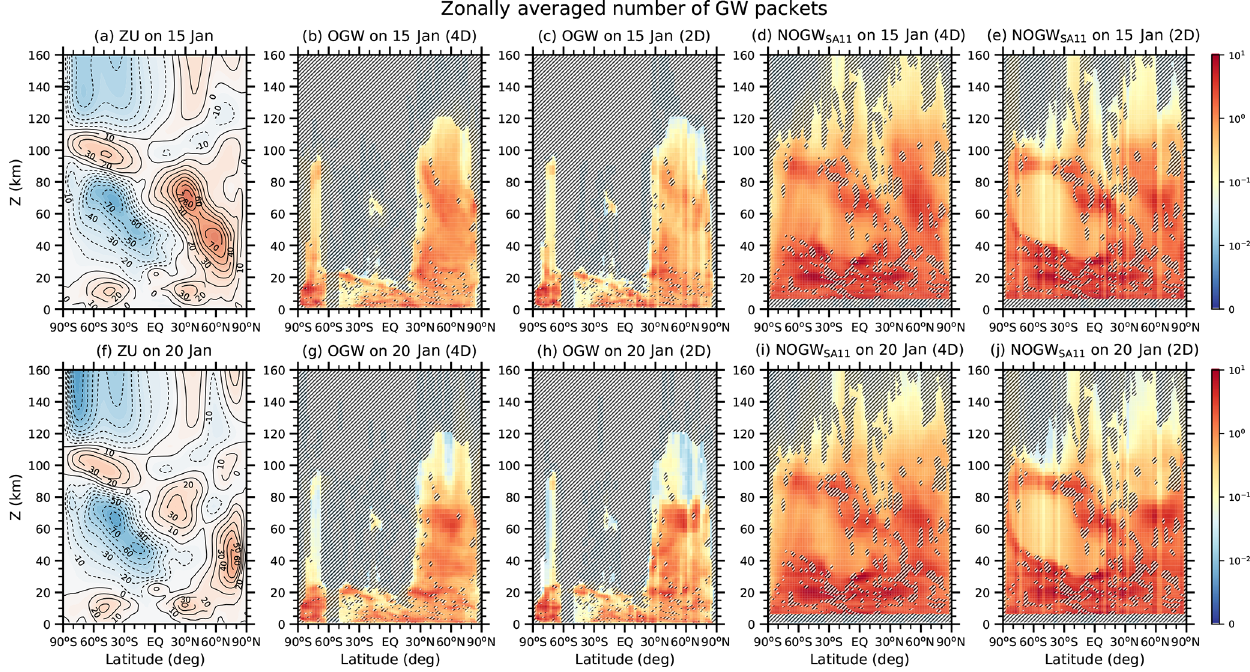
Figure 8. Same as Fig. 7 except for the zonally averaged number of GW